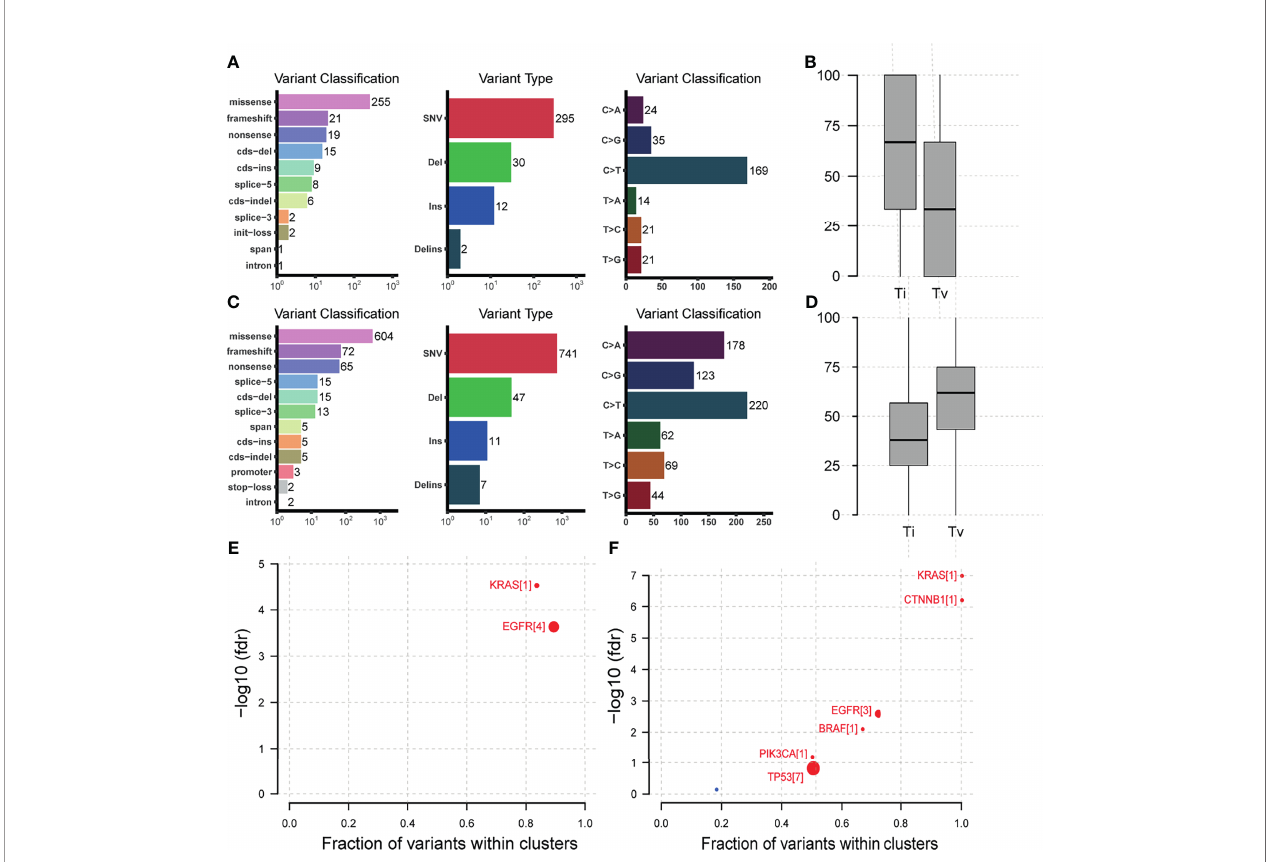
FIGURE 4 | Mutation types, base substitution types, and driver gene status in the 165-sample cohort. (A) Mutation types, base substitution types of the young lung cancer group. (B) Transition and transversion fractions of the young lung cancer group. (C) Mutation types, base substitution types of the old lung cancer group. (D) Transition and transversion fractions of the old lung cancer group. (E) Driver gene status of the young lung cancer group. (F) Driver gene status of the old lung cancer